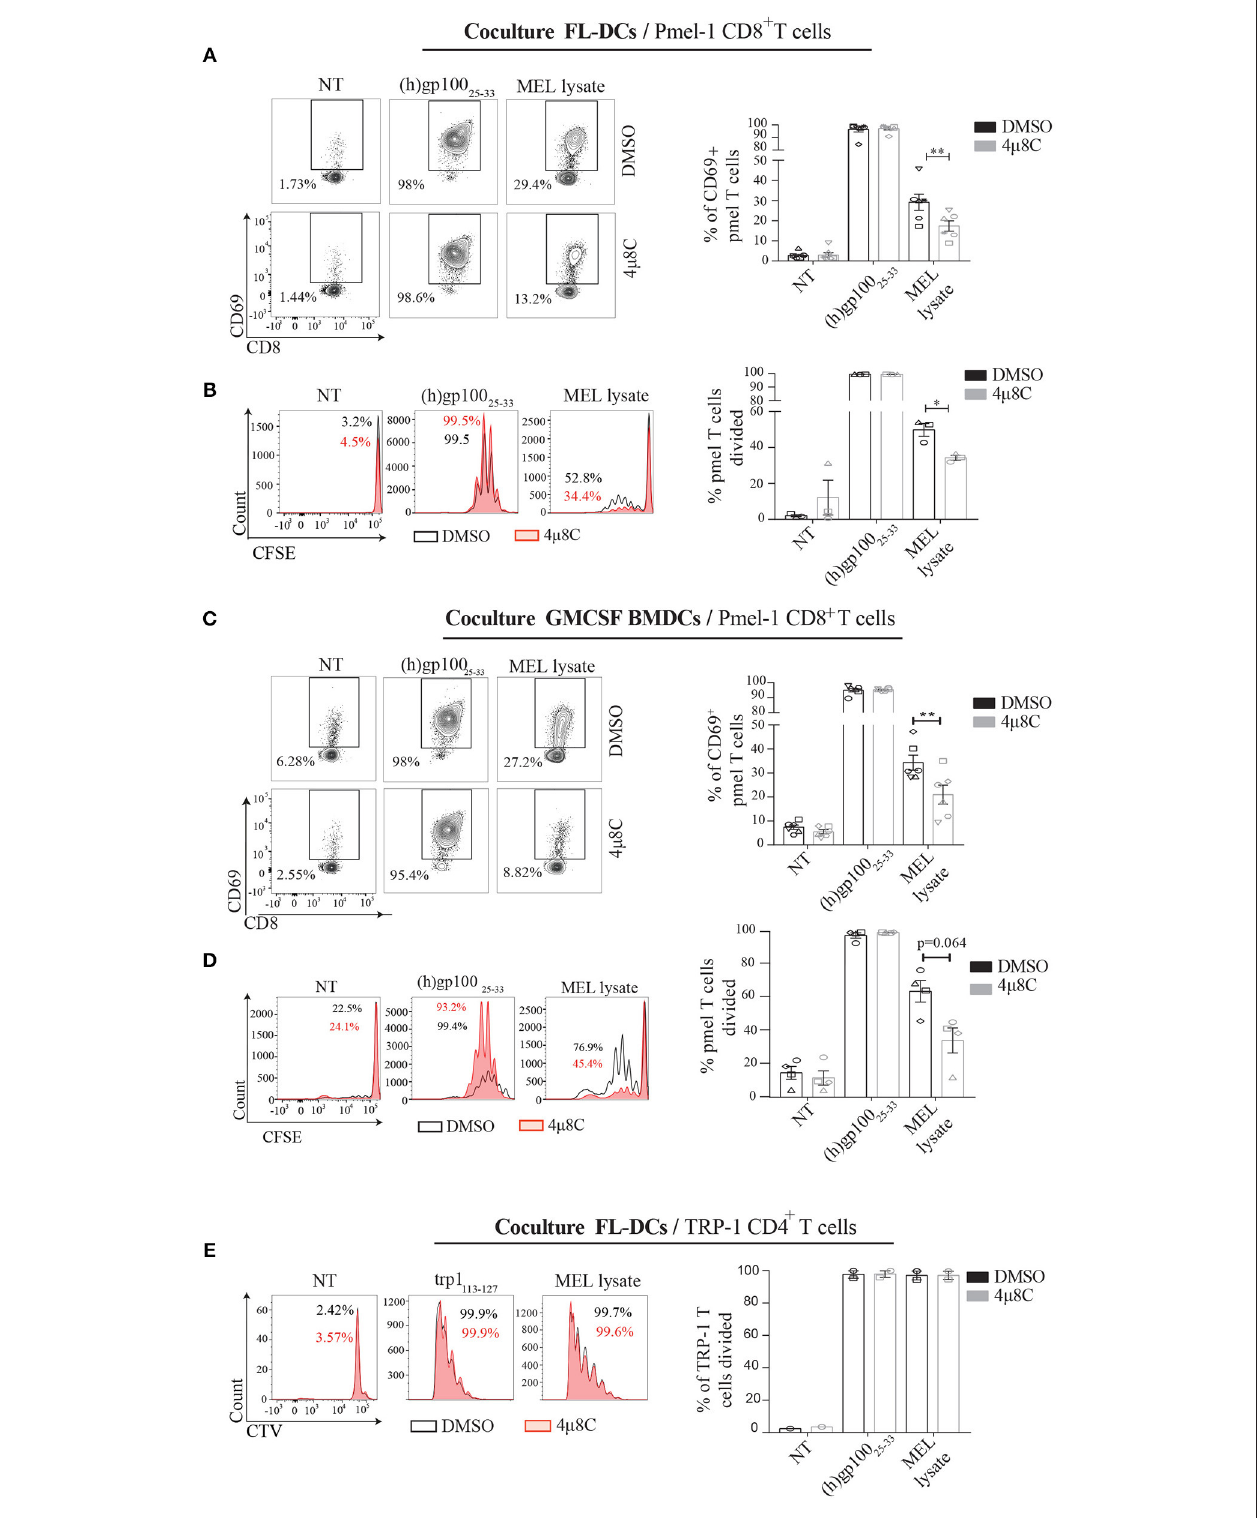
FIGURE 5 | Inhibition of IRE1 α endonuclease function reduces the cross-presentation of a melanoma-endogenous antigen in vitro . (A) FL-DCs were preincubated with 50 µ M 4 µ 8C or DMSO for 6h and pulsed with 100 µ g/ml MEL for the last 5h of culture. Alternatively, cells were pulsed with 2.5 µ M human gp100 peptide for the last 20min of culture. Cells were counted, fixed and 5 × 10 4 FL-DCs were cocultured with 5 × 10 4 pmel-1 CD8 + T cells. Pmel-1 CD8 + T cell activation